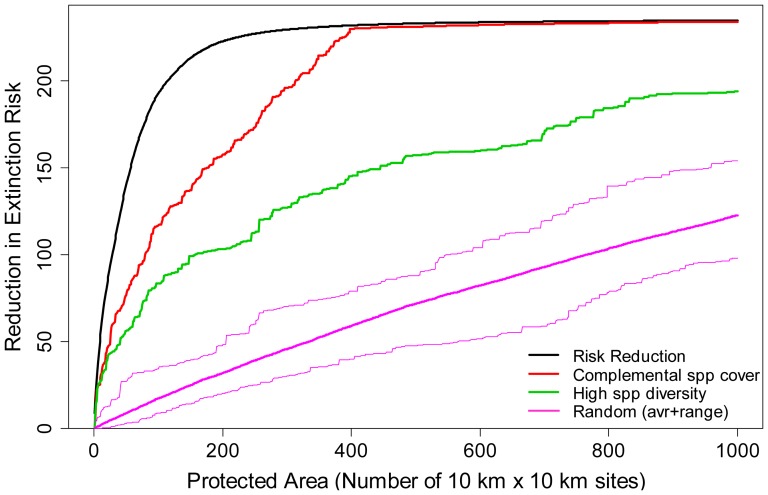
Comparison of performance among spatial prioritization methods in terms of reduction in extinction risk.“Risk Reduction”: cell selection using SPERS. “Complemental spp. cover”: complementarity analysis in which cells are incrementally selected using a greedy algorithm to maximize the number of represented species in the protected areas; after all species are represented in at least one cell, the algorithm proceeds so that all species are represented in more cells. “High spp. diversity”: hotspot analysis in which cells are incrementally selected according to species richness in them. “Random”: cells are added randomly to protected areas and the random selection is performed 100 times; thick pink curve  =  mean, thin pink curves  =  maximum–minimum range.